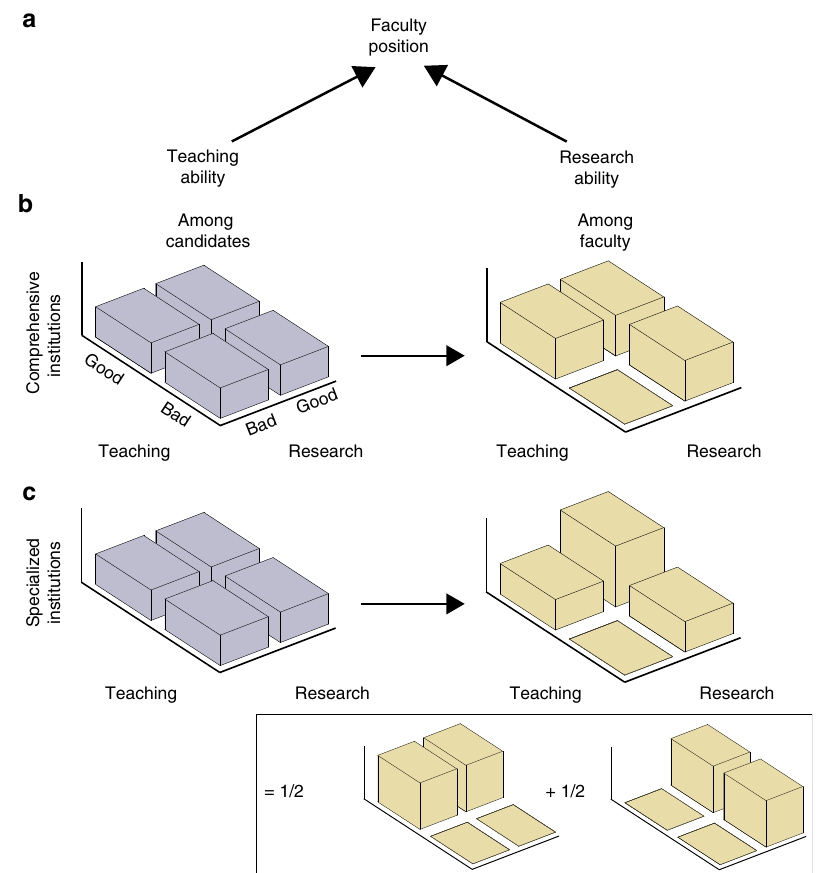
Figure 1 | An illustration of Berkson’s effect when hiring faculty in different institutions. ( a ) When applying for faculty positions, a candidate’s success generally depends on their skills at both teaching and research. We assume that these abilities are statistically independent in the overall field of applicants. ( b ) At comprehensive institutions, the hiring process considers both skills and eliminates candidates who are both bad teachers and bad researchers. Consequently, the two abilities become negatively correlated among successful candidates. ( c ) A set of specialized institutions, each one dedicated either purely to teaching or purely to research, select faculty based solely on the relevant ability in each case—a probabilistic mixture of both causal mechanisms as shown in the inset. Knowing that a candidate was successful in this scenario only reveals information about one of their abilities, and consequently induces weaker negative correlations than in b , due to the larger fraction of faculty members who are skilled at